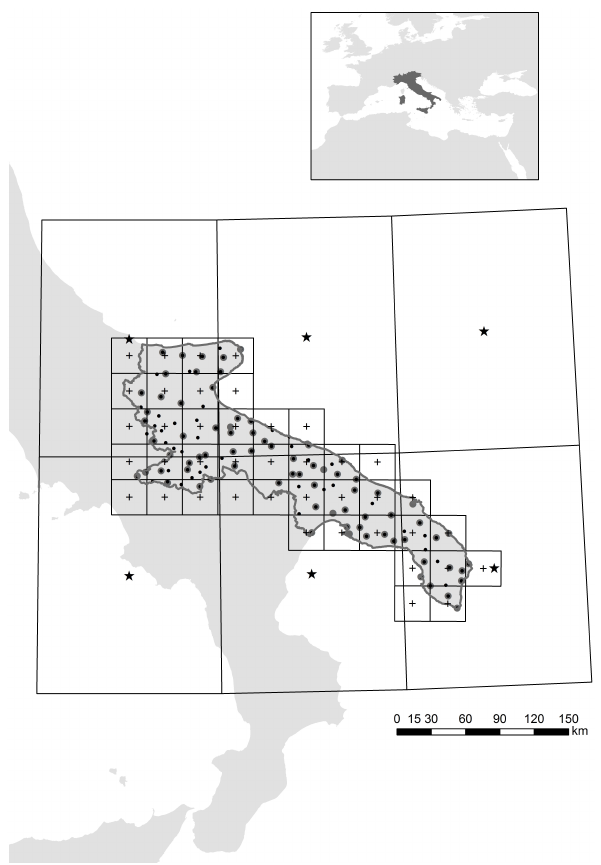
Fig. 3. Location of Apulia region. The hydrological domain area is delimited by a grey full line. Locations of the temperature and precipitation sampling stations are shown with grey and black full circle, respectively. GCM nodes are shown with black stars and DD nodes are shown with black crosses. The grid boxes associated with GCM and DD nodes are delimited by black full